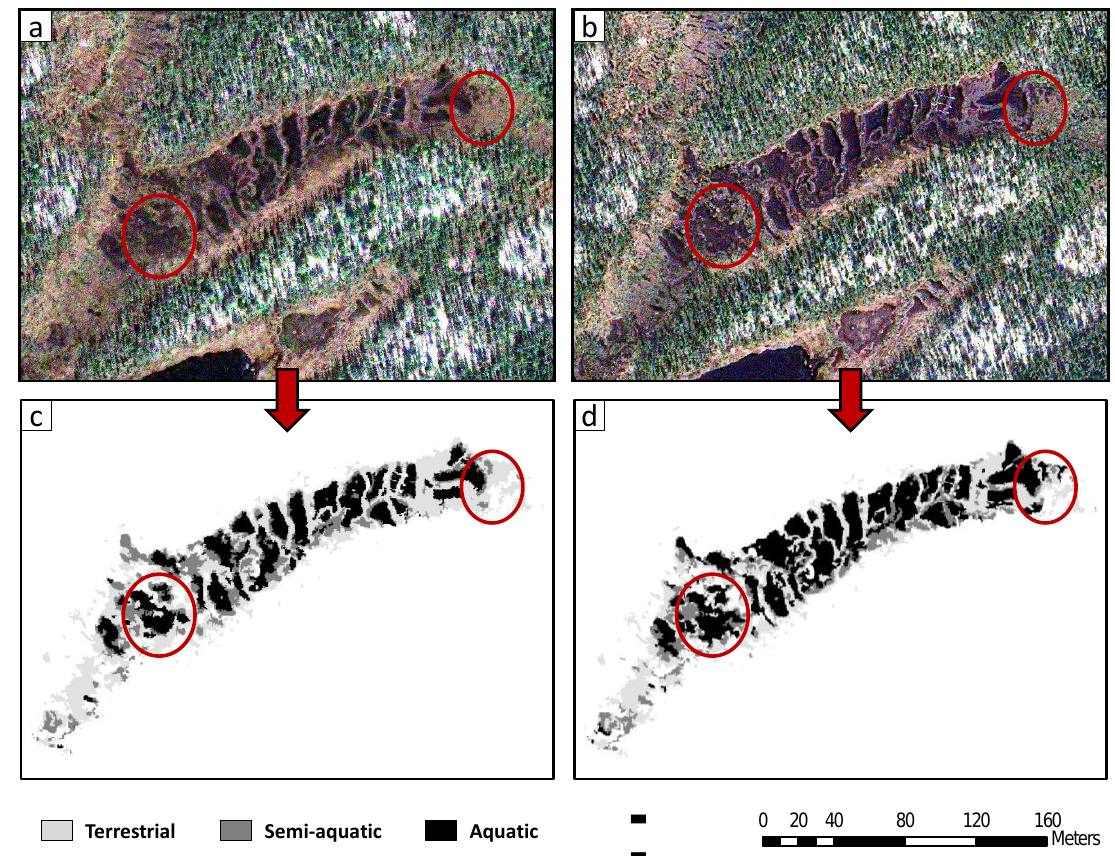
Figure 10. Comparison between ( a ) 13 September 2009 and ( b ) 30 August 2010 GeoEye-1 RGB images (subsets centered on site 2: 54°06′41″N, 72°30′56″W), and the respective aquatic, semi-aquatic, and terrestrial proportions of the site 2 saturated zone ( c , d ). Areas of major change are encircled in